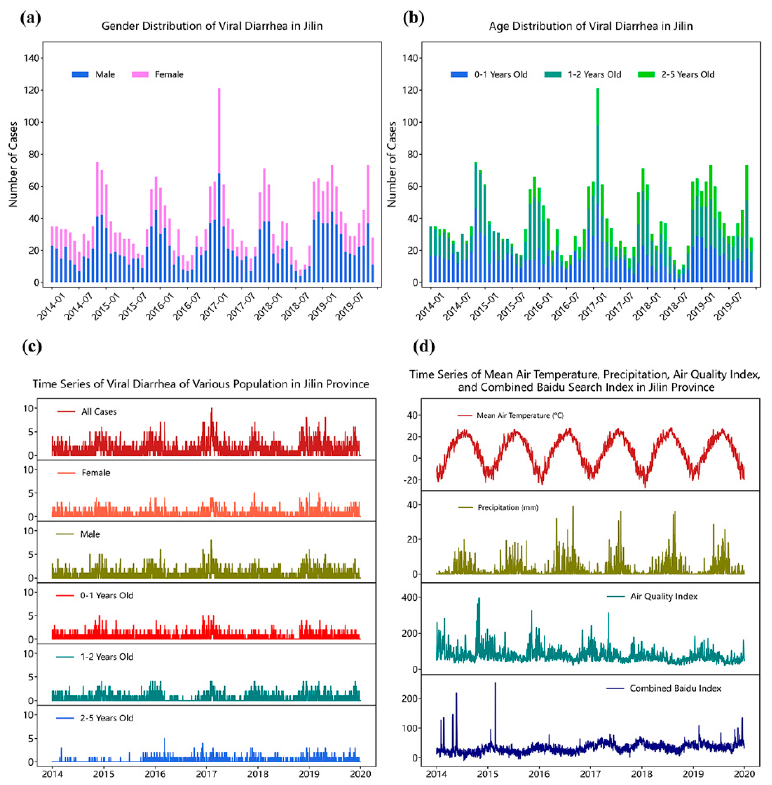
Figure 1. Epidemiology of viral diarrhea among children under 5 years old in Jilin Province from 2014 to 2019 and time-series data of the selected external factors. ( a ) Gender distribution of monthly cases of viral diarrhea; ( b ) Age distribution of monthly cases of viral diarrhea; ( c ) Time series of the total number of viral diarrhea cases among children and those in different subgroups; ( d ) Time series of the selected external factors.